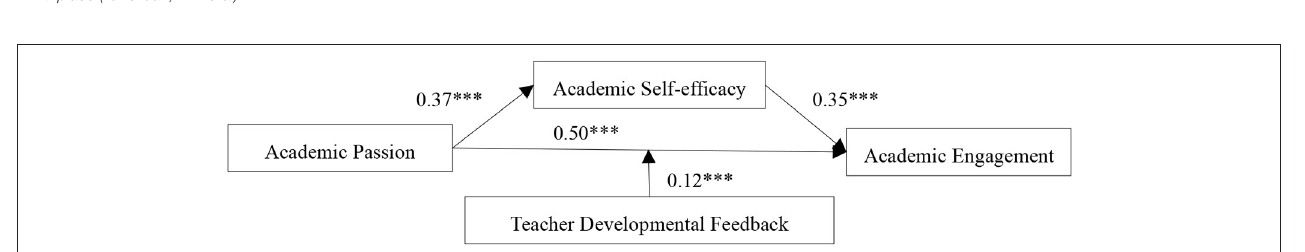
FIGURE 2 | Roadmap of the influence of academic passion on academic engagement. *** p <